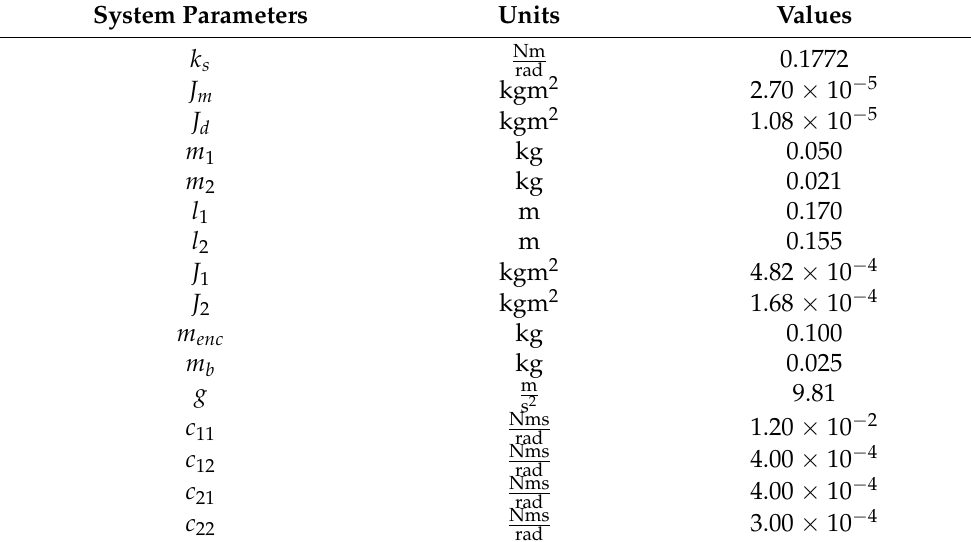
N B = 1. All the relevant system parameters are defined in Table 1. Table 1. System